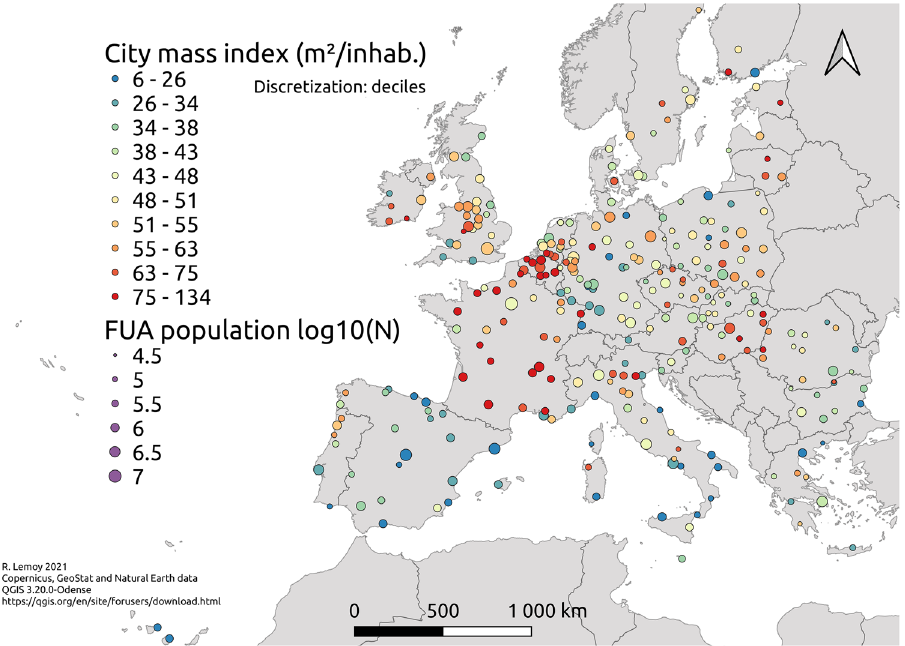
Figure 4. Map of the city mass index CMI, showing a clear national effect. The size of symbols indicates the decimal logarithm of FUA population N . The map is made using Copernicus, GeoStat and Natural Earth data with QGIS